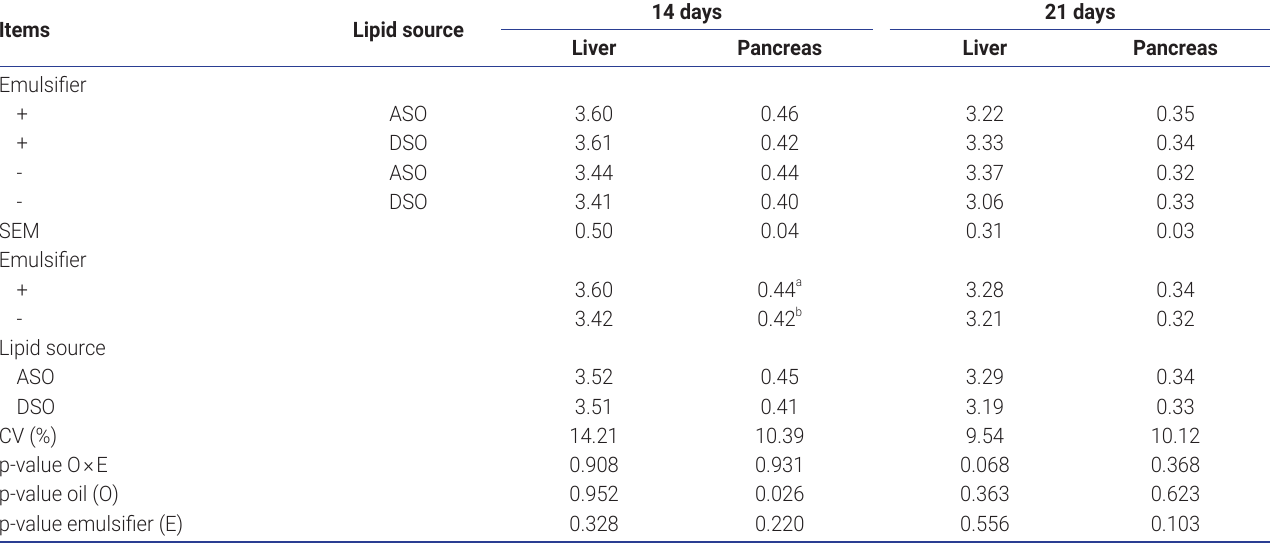
Table 5. Relative weight (%) of liver and pancreas of broilers fed diets containing different lipid sources, with or without emulsifier Items Lipid